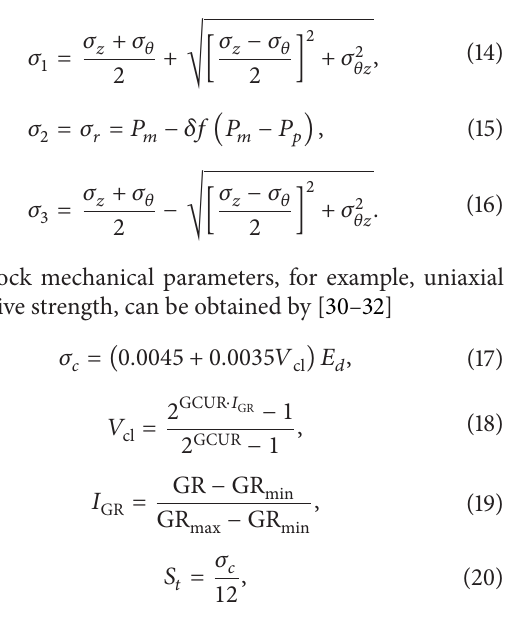
Figure 7: Fracture pressure versus well azimuth in the depleted reservoir with 𝑡 𝑐 = 7